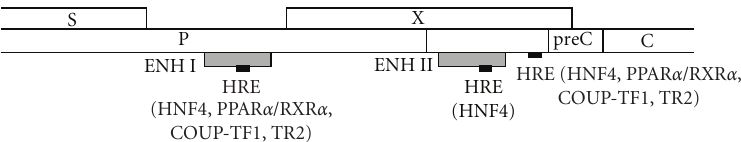
Figure 2: NR regulatory region in HBV genome . Schematic diagram of the HBV genome. The viral polymerase (P), surface proteins (S), precore (preC), core (C), and X protein (X) open reading frames are indicated by open rectangular boxes. Enhancers (ENHs) I and II are indicated by grey rectangular boxes. The hormone response elements (HREs) are indicated by small black rectangular boxes. Nuclear receptors that can bind these HREs are indicated into